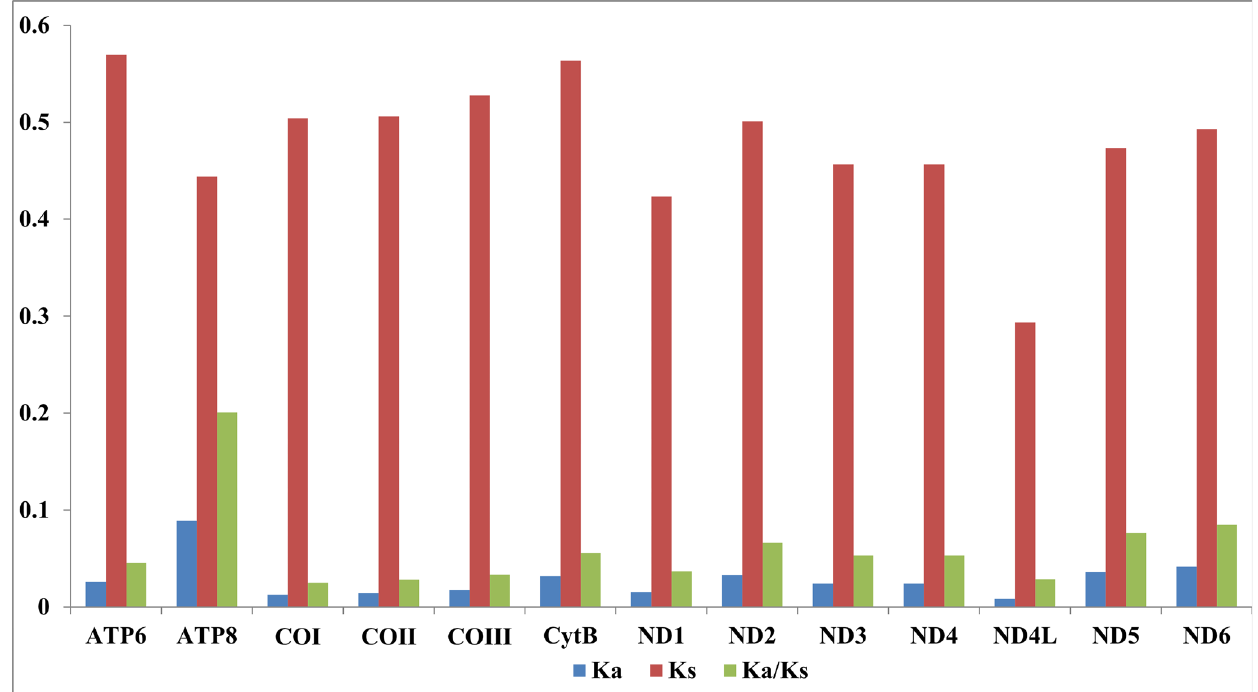
Figure 3. Evolution rate of 13 PCGs of mitogenomes of 15 Chironomus species. Ka refers to non- synonymous nucleotide substitutions, Ks refers to synonymous nucleotide substitutions, Ka/Ks refers to the selection pressure of each PCG. The x axis represents 13 PCGs, and the y axis represents the value.